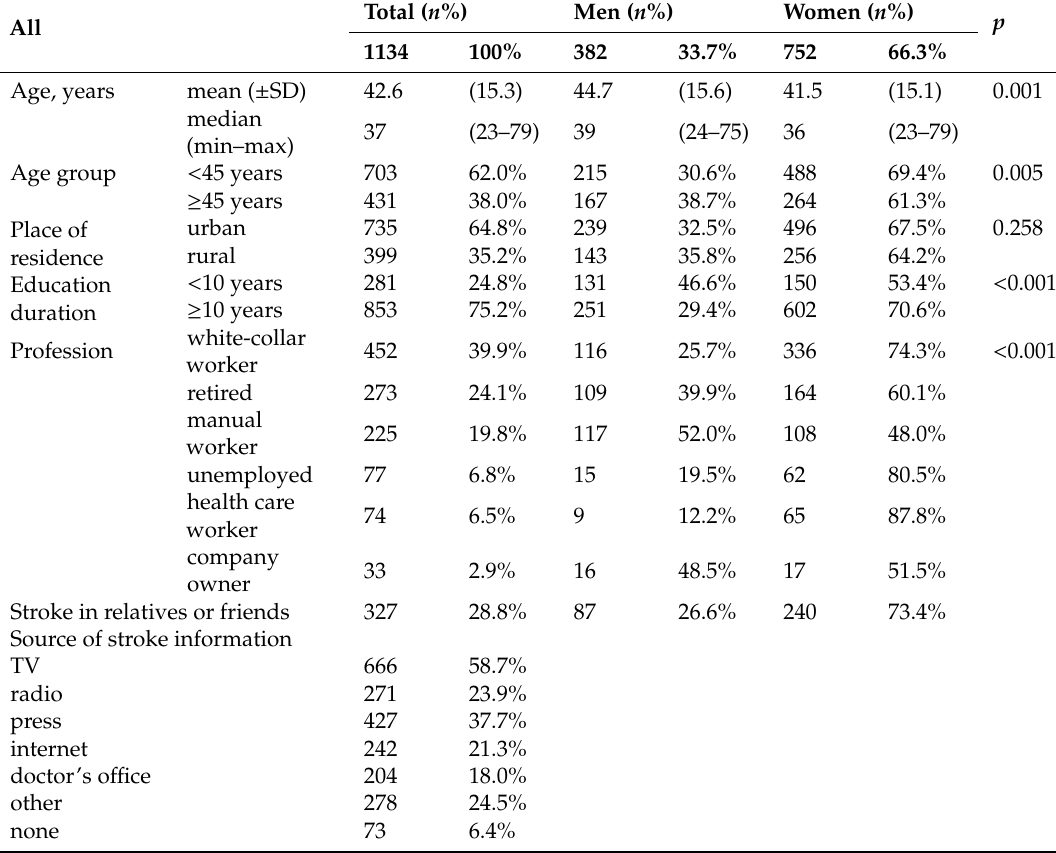
Table 1. Group characteristics and source of information about